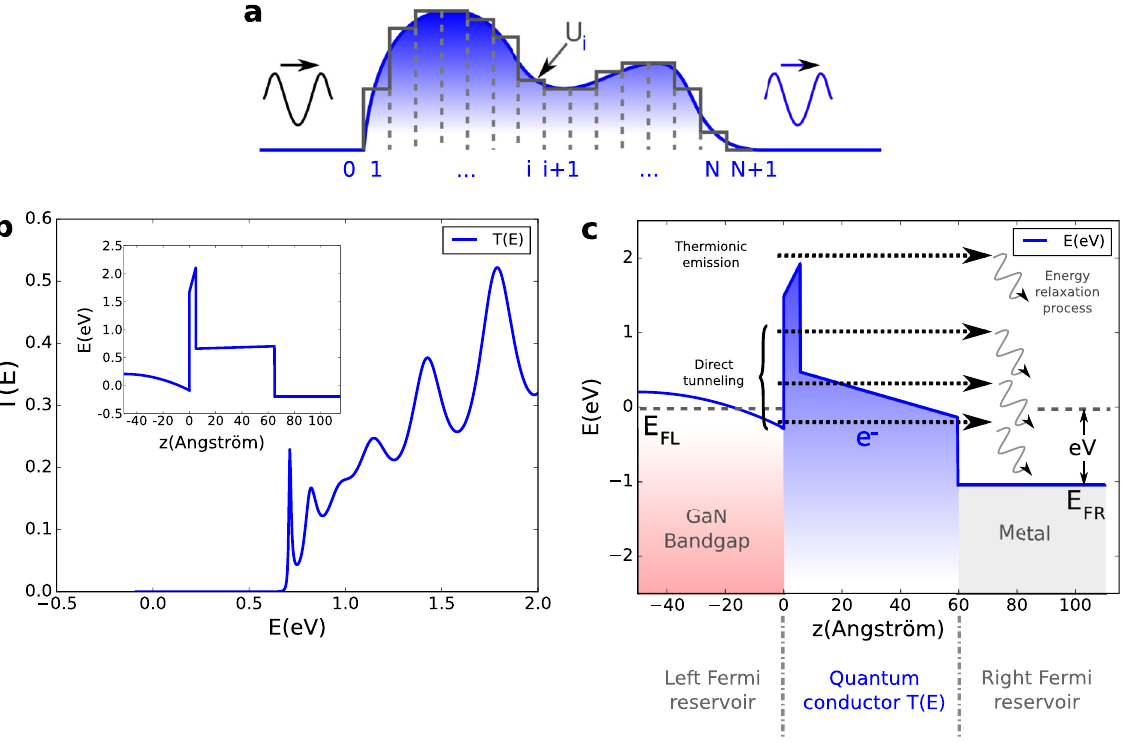
Figure 5. Electron transmission probability. ( a ) Arbitrary potential barrier discretization. ( b ) Transmission probability as a function of energy at V = 200 mV and T = 300 K calculated using the transfer matrix formalism. Inset : Associated recessed anode conduction band profile. ( c ) Schematic representation of various electron tunneling events accounted for in the recessed anode diode using the Tsu-Esaki